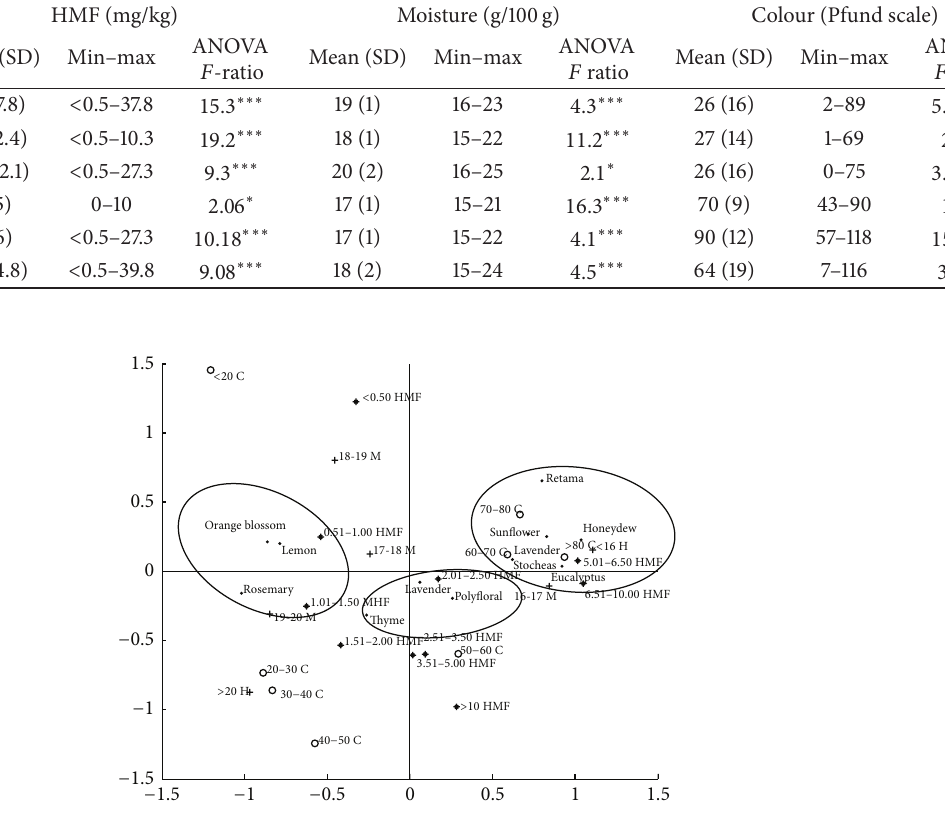
Figure 2: Multiple correspondence analyses of the quality parameters coded as intervals with projected varieties of honey. M: moisture; C: colour; HMF: